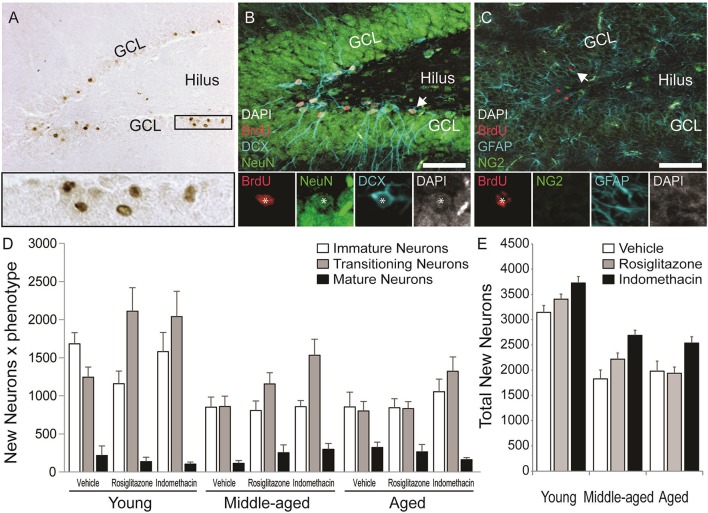
Age decreased but indomethacin treatment increased new neuron numbers. (A) Photomicrograph image of BrdU+ (in brown) cells taken under a 10x objective (inset shows BrdU+ cells under a 40x objective). Confocal images taken under a 20x objective with 1.5x digital zoom of (B) BrdU+ cells (in red) expressing immature DCX+ (in blue), transitioning (DCX+/NeuN+), and mature NeuN+ (in green) neuronal phenotypes and (C) Cells expressing NG2+ oligodendrocyte precursor and GFAP+ astrocyte phenotypes (in blue). The inset in (B) shows each marker for a transitioning neuron and in (C) a new astrocyte. (D) The mean (±S.E.M.) number of new immature (white bars), transitioning (gray bars) and mature (black bars) neurons in the hippocampi of vehicle-, rosiglitazone-, and indomethacin-treated young, middle-aged, and aged rats. Most new cells were transitioning (p < 0.0001 vs. other phenotypes) and then immature neurons (p < 0.0001 vs. mature neurons) and these more of these neurons were found in young vs. middle-aged and aged rats (all p < 0.0001). The number of transitioning neurons was highest (p < 0.01 vs. all other phenotypes) and new immature neurons next highest (p < 0.001 vs. mature neurons and glia) in young and middle-aged rats, but numbers of both phenotypes were similar in aged rats (both p < 0.0001 vs. mature neurons). Panel (E) shows the total number of new neurons in vehicle- (white bars), rosiglitazone- (gray bars), and indomethacin- (in black bars) treated rats. Young rats had more new neurons than middle-aged and aged (p < 0.001) rats and indomethacin-treated rats had more new neurons than vehicle- (p < 0.001) and rosiglitazone- (p < 0.01) treated rats.